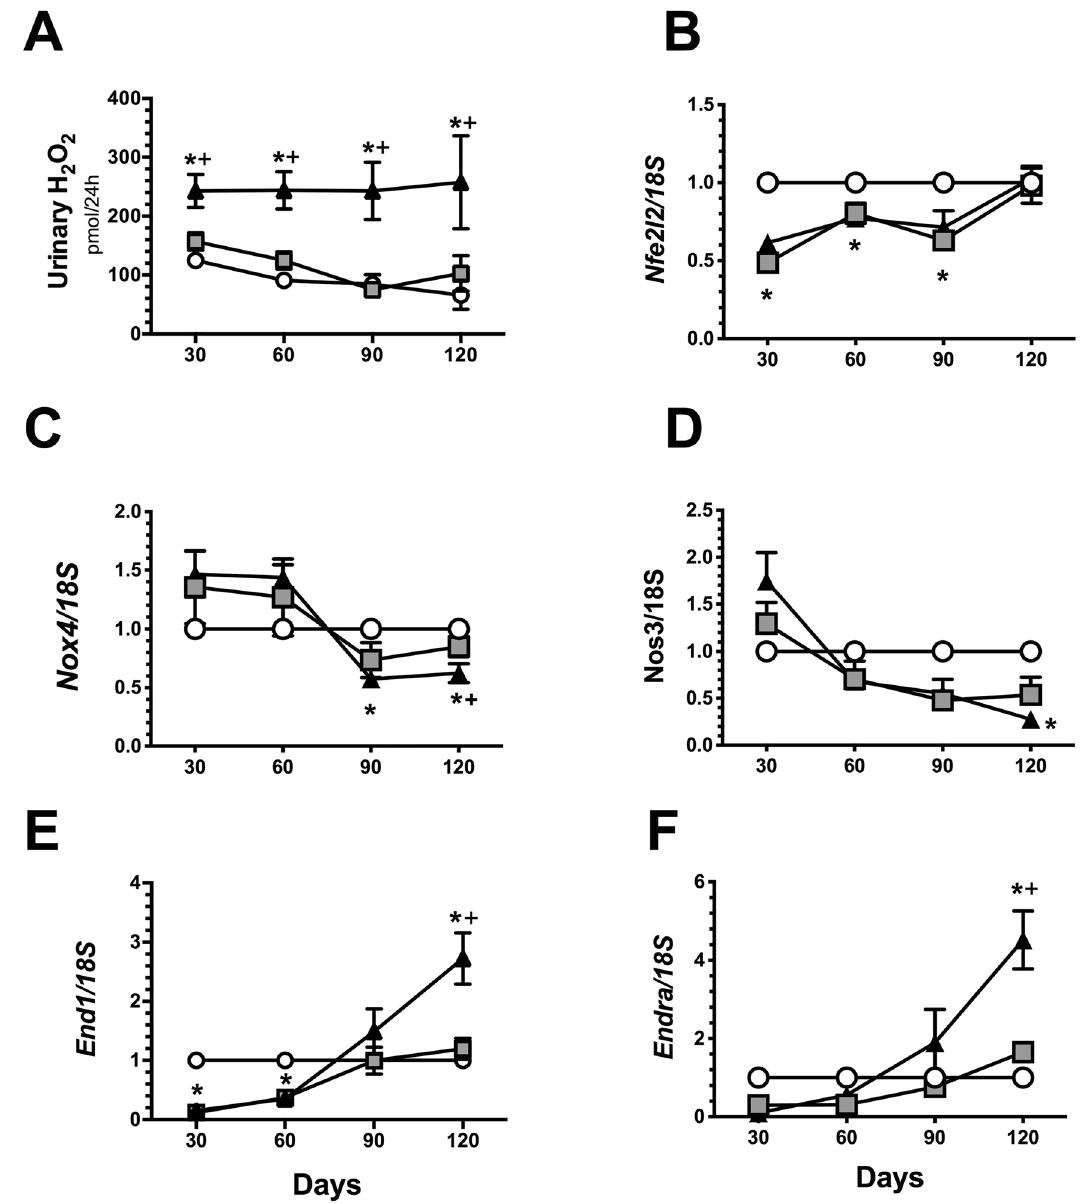
Figure 4. Oxidative stress and vasoactive mediators over the course of AKI to CKD transition. ( A ) Urinary hydrogen peroxide, ( B ) mRNA levels of Nfe2l2 ( C ) mRNA levels of Nos3, ( D ) mRNA levels of NOX4, ( E ) mRNA levels of Edn1 and ( F ) mRNA levels of endothelin receptor A ( Endra ). Data are represented as the mean ± SE. n = 4, n = 4, and n = 5 for the S, UNx, and IR + UNx groups, in each studied period: 30, 60, 90, and 120 days post-ischemia. The one-way analysis of variance (ANOVA) was used to determine statistical differences, using the Bonferroni correction for multiple comparisons. * p < 0.05 versus S group and + p < 0.05 versus UNx group in their respective